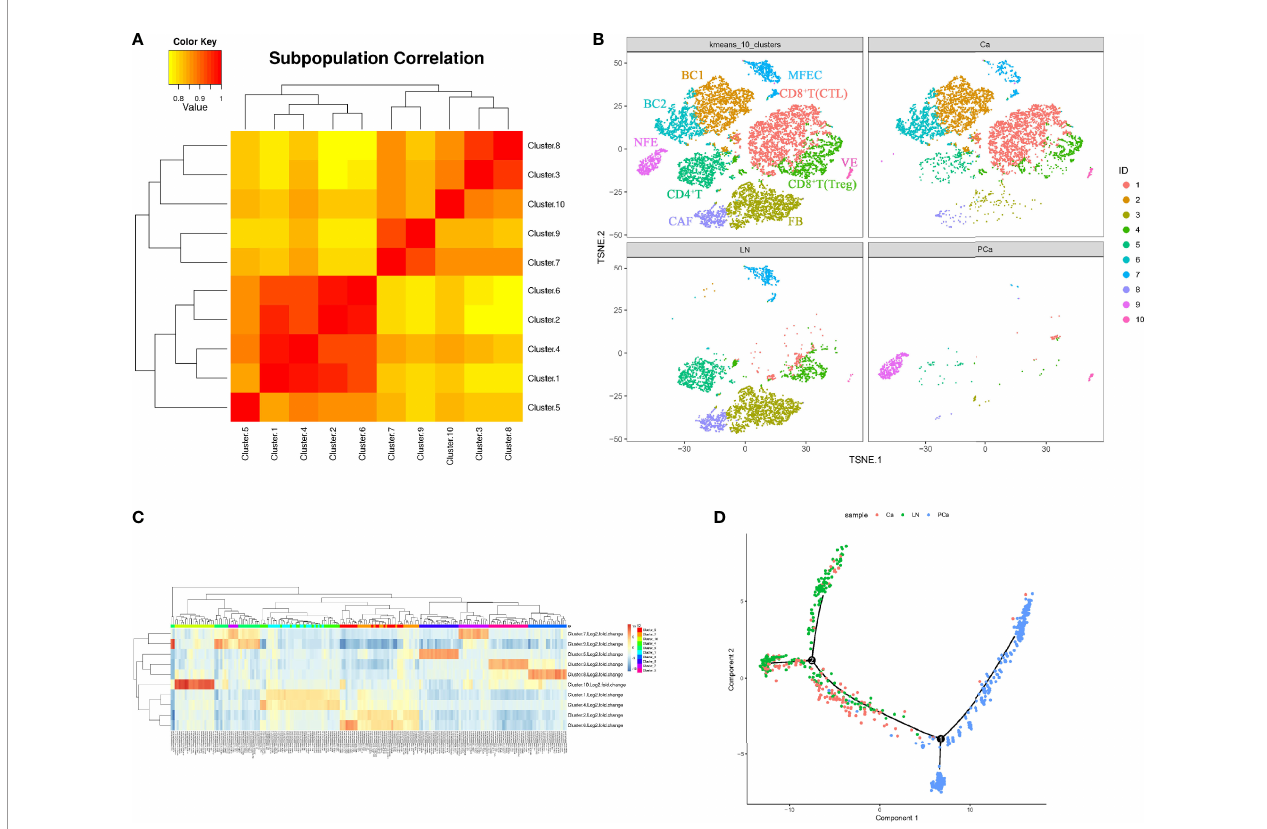
FIGURE 3 | Cellular heterogeneity during PTC progression (Ca, primary PTC; LN, lymph node metastasis; PCa, paracancerous tissue). (A) Diagram of cell cluster correlation. (B) Aggregate analysis of ecosystems in paracancerous, primary and metastatic PTCs. The t-SNE plot of aggregate analysis from paracancerous, primary and metastatic PTCs, showing the formation of 10 main clusters shown in different colors. The functional description of each cluster is determined by the gene expression characteristics of each cluster. Cluster1: CD8+T(CTL); Cluster2: BC1; Cluster3: FB; Cluster4: CD8+T(Treg); Cluster5: CD4+T;Cluster6: BC2; Cluster7: MFEC; Cluster8: CAF; Cluster9: NFE; Cluster10: VE. (C) Heatmap illustrating expression levels of speci fi c markers in each cell cluster. Detailed different genes were listed in Supplementary Table 2 . Expression data are calculated as Log2 Fold Change. (D) Pseudotime PTC trajectory analysis. Each point corresponds to a single cell, and each color represents a sample. NFE, Normal Follicular Epithelial cell; ME, Malignant Epithelial cell; VE, Vascular Endothelium cell; FB, Fibroblast cell; CAF, Cancer-associated fi broblast; Treg, Regulatory T cell; Th, helper T cell; BC, B